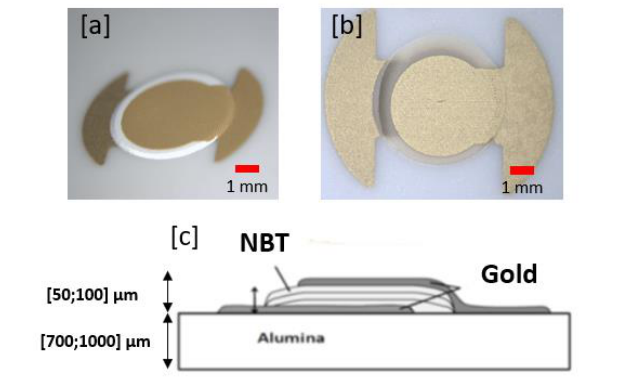
Figure 1 : (a) Piezoelectric element before sintering (b) Piezoelectric element after sintering (c) Cut view of the sensor showing the stacking of gold-NBT-